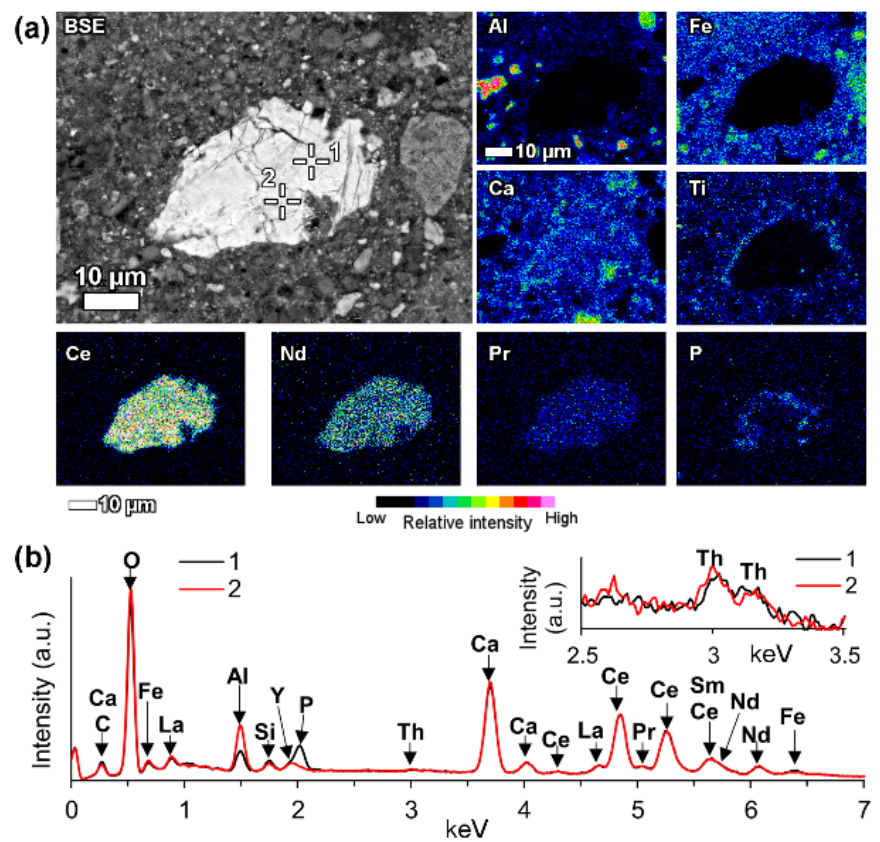
Figure 16. A mixed type REE particle shown on ( a ) backscattered electron image with respective EDS elemental maps and ( b ) EDS spectrograms corresponding to indicated spot